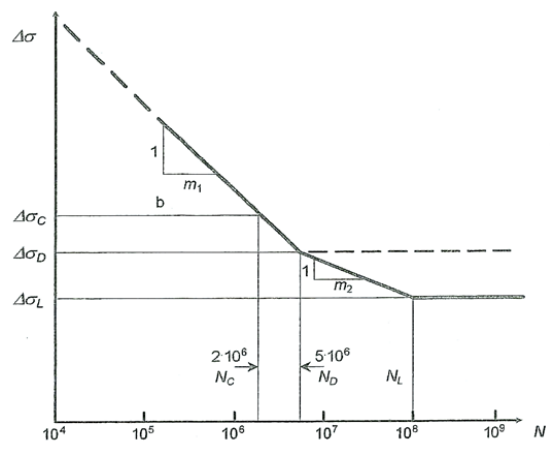
Figura 4: Curva di resistenza a fatica per giunti saldati in lega d’alluminio secondo l’Eurocodice 9 [8].